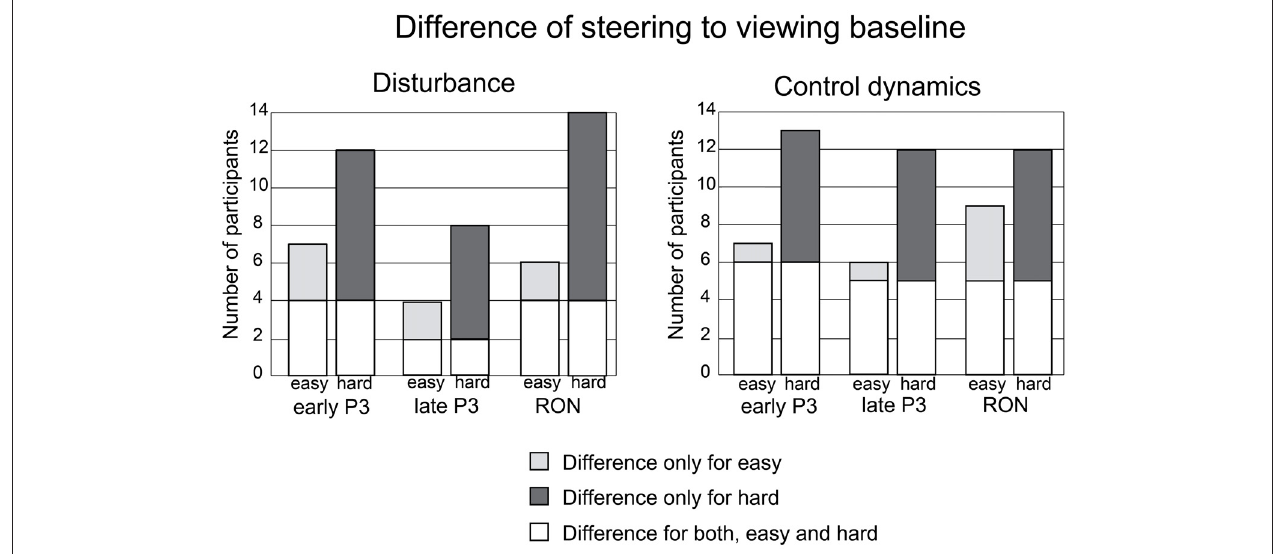
FIGURE 6 | Permutation tests were performed to evaluate steering manipulations of the disturbance (left) and control dynamics (right). Bar plots indicate the number of participants that exhibit a significant difference in their early P3, late P3 and RON for the steering condition (“easy”, ”hard”) relative to the viewing baseline. White bars indicate participants who showed a reliable difference for both “easy” and “hard” conditions. Light/Dark gray bars indicate participants who showed a reliable difference for only the “easy”/“hard” condition.